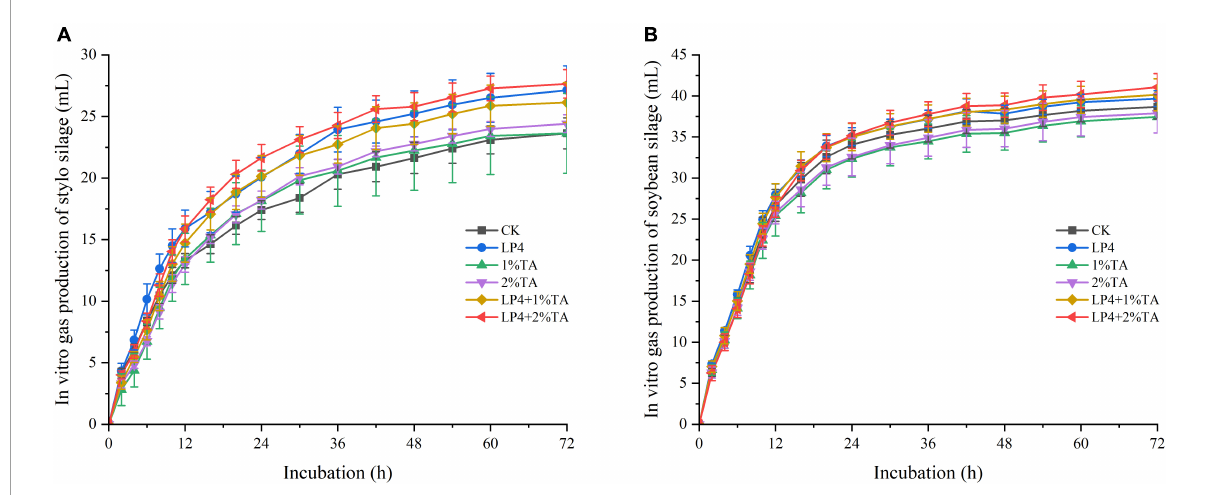
FIGURE1 In vitro gas production and dry matter digestibility of different treatments of Stylosanthes silage (A) and whole-plant soybean (WPS) silage (B) in 72 h.